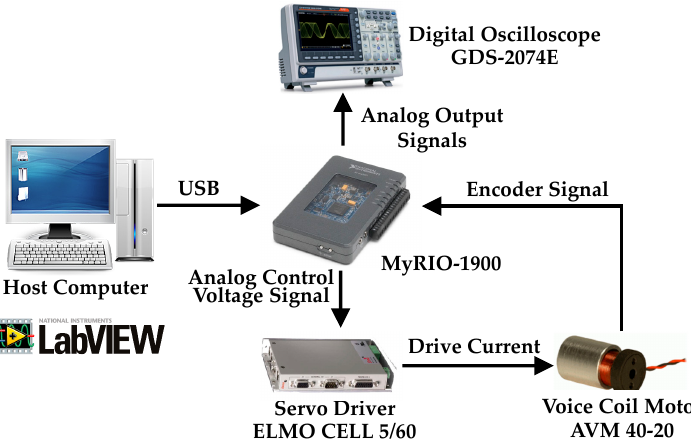
Figure 5. Experimental setup of the voice coil motor (VCM) control system.